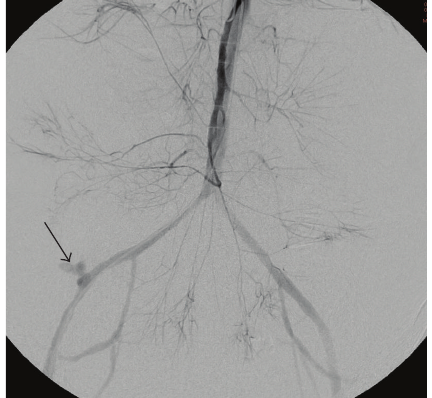
Figure 1: Hand injection of the superior mesenteric artery with reflux into the aorta demonstrates contrast extravasation (arrow) from the right external iliac artery stump, in the region of the patient’s pancreatic transplant. Additionally, there is significant mesenteric